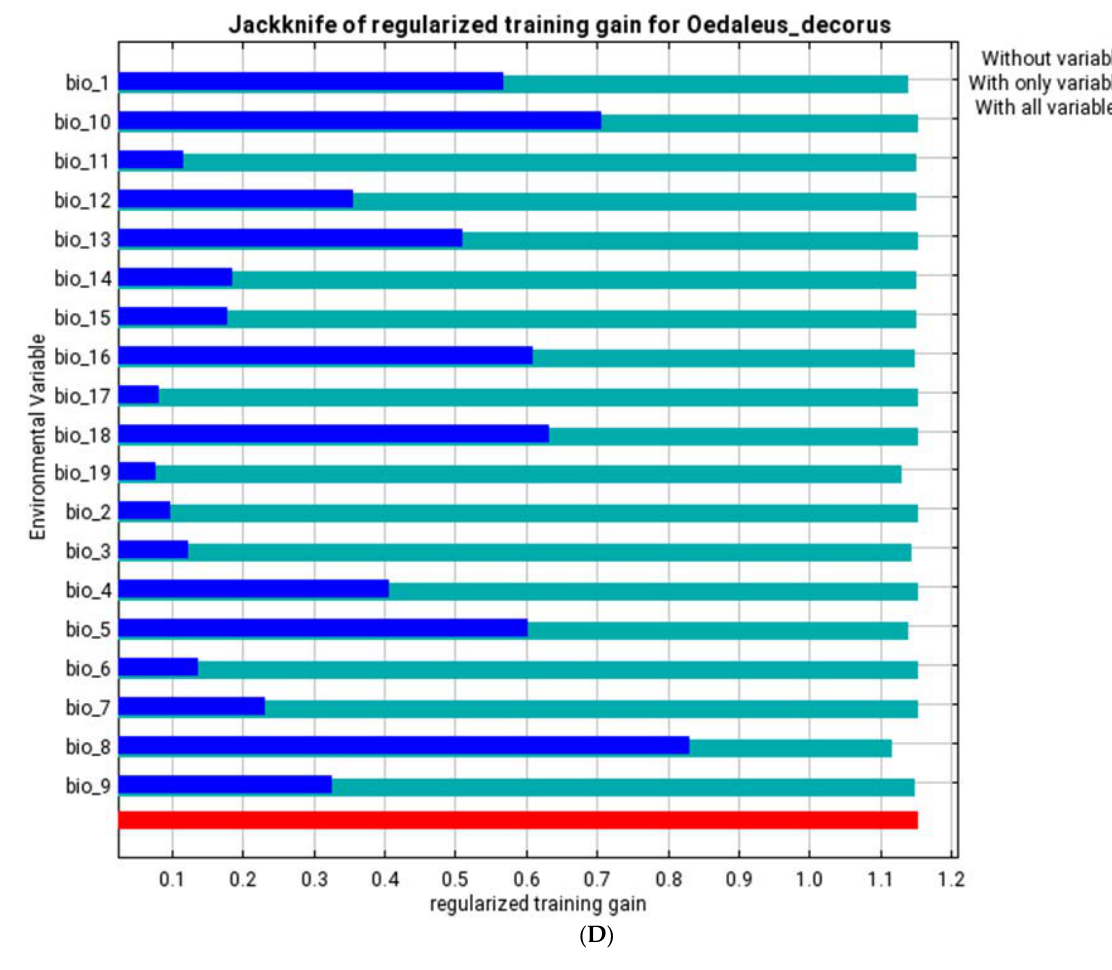
Figure 7. Jackknife of regularized training gain for the Oedaleus decorus distribution models for the south-eastern part of the West Siberian Plain: ( A )—distribution data before 1961 and bioclimatic variables for 1970–2000; ( B )—distribution data from 1961 until 2021 and bioclimatic variables for 1970–2000; ( C )—distribution data from 1961 until 2021 and forecasts of bioclimatic variables from the climatic model CNRM-ESM2-1; ( D )—distribution data from 1961 until 2021 and forecasts of bioclimatic variables from the climatic model MIROC6.